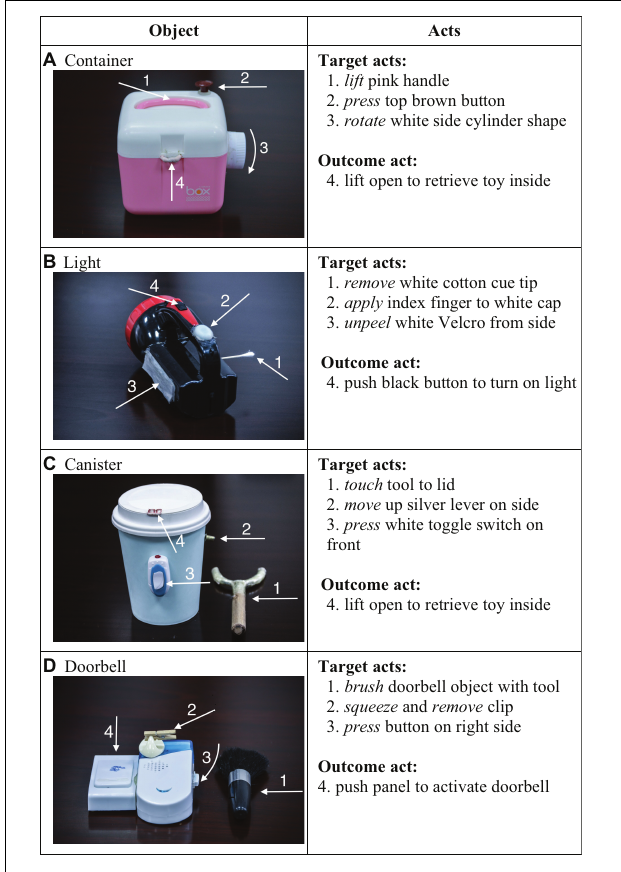
FIGURE 1 | Photographs of the four test objects (A–D) , as well as verbal descriptions of the three novel target acts and the final outcome act for each object. See Figure 2 for human